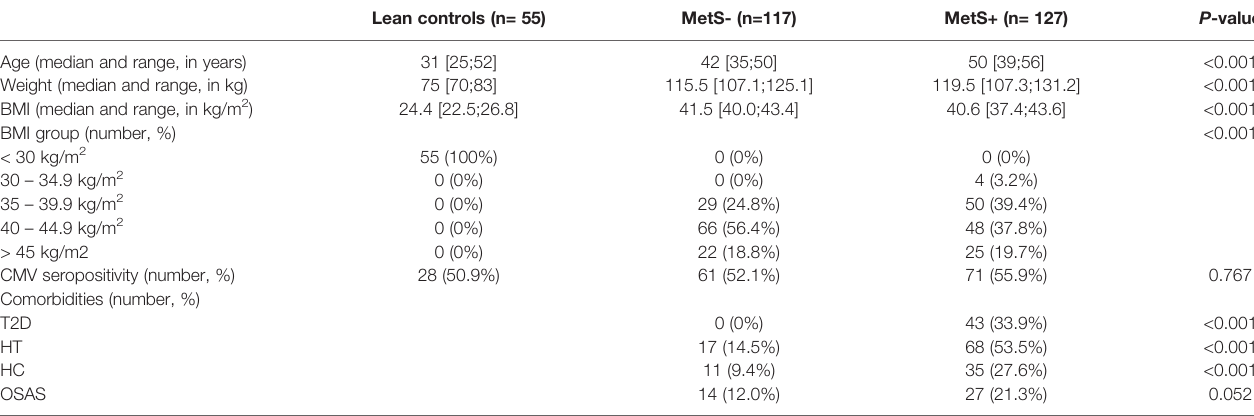
TABLE 1 | Baseline characteristics.